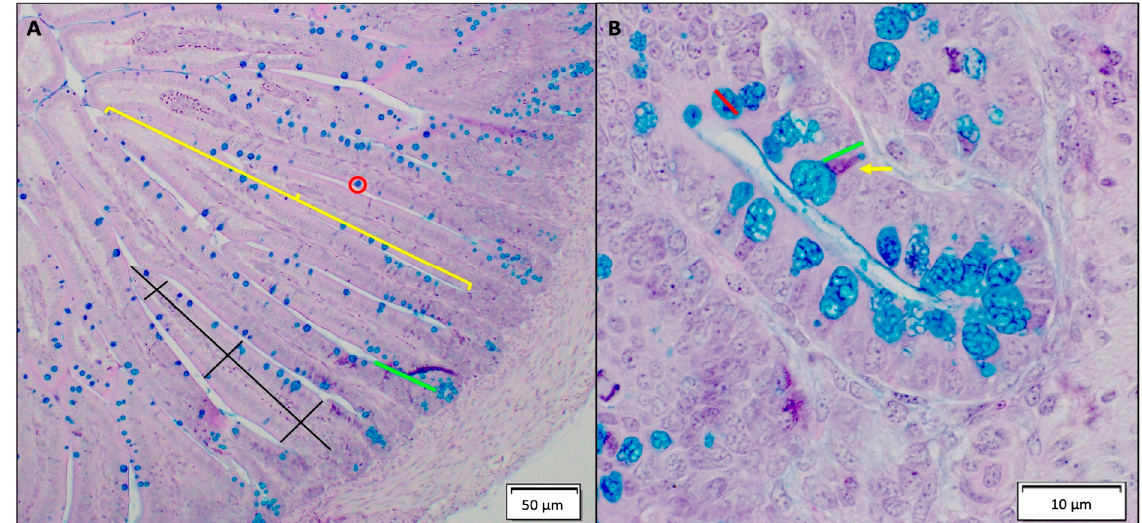
Figure 1. ( A ) Histomorphological depiction of a normal small intestine. Enterocytes are located within the small intestine villi, and goblet cells are the blue cells within the enterocyte (red circle). The crypt villus axis is represented with a yellow bar demonstrating where the axis is located. The following variables were measured: villus surface area (depicted in black) and crypt depth (depicted in green). ( B ) Histomorphological depiction of a normal small intestinal crypt. Paneth cells (yellow arrow, pyramidal shape) play a key role in innate intestinal immunity and homeostasis. The following variables were measured: goblet cell diameter (red) and Paneth cell diameter (green). The type of goblet cell shown for the goblet cell diameter measurement example represents an acidic goblet cell: the predominant goblet cell type found in the study.